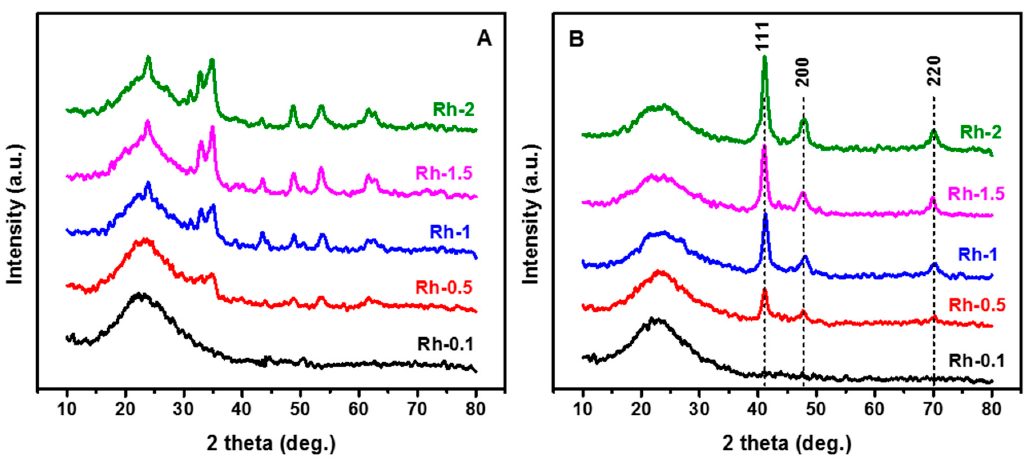
Figure 2. XRD patterns of the prepared Rh-TUD-1 samples: ( A ) The as-synthetized samples, and ( B ) the hydrogenated samples and the formation of the final products.